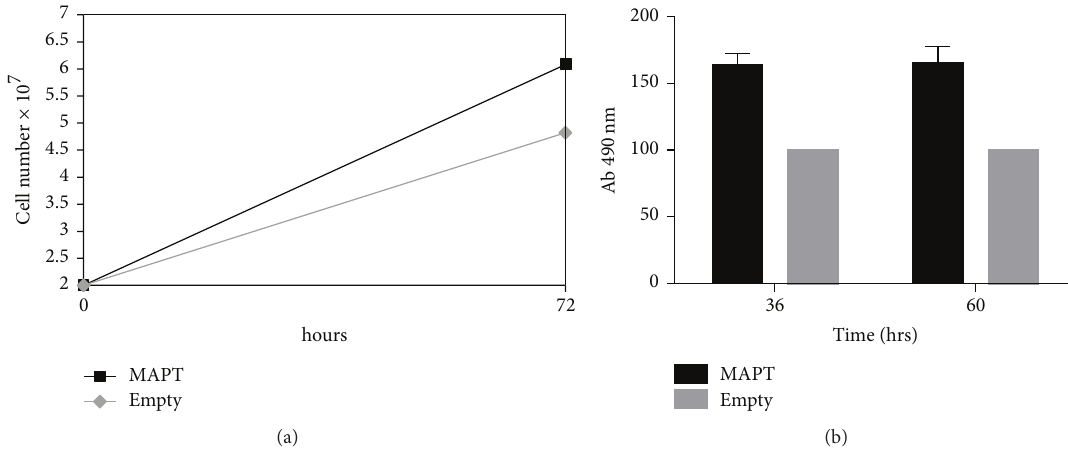
Figure 5: (a) Cell proliferation. Growth rate of MAPT overexpressing cell line versus Empty; 𝑝 < 0.05 . Presented data are means from three independent experiments ± SD. (b) MTT colorimetric assay (over a time period of 60 h) comparing MAPT overexpressing Rin-5F cell line versus Empty; 𝑝 < 0.05 . Presented data are means calculated from three independent experiments ±